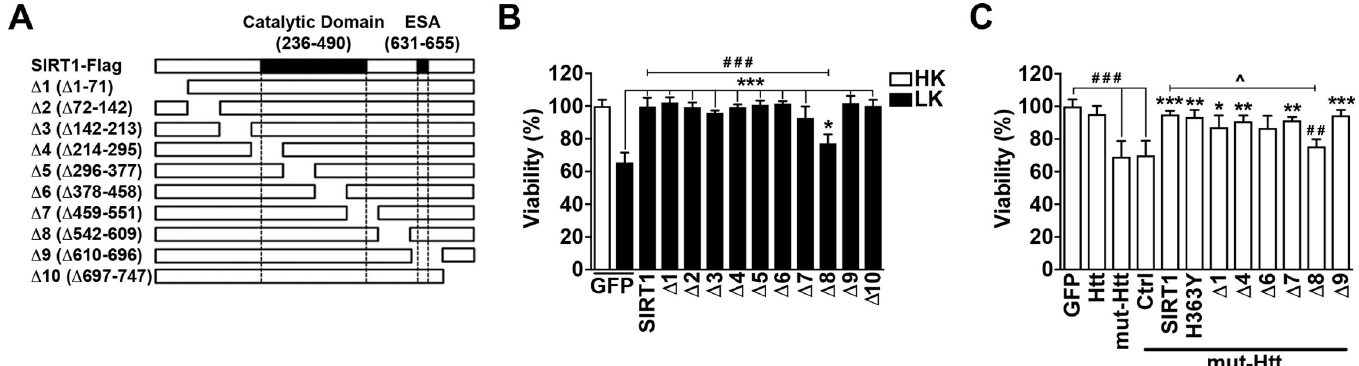
Fig 1. Neuroprotection by SIRT1 does not require its deacetylase activity. A. Schematic of the Flag-tagged SIRT1 and ten deletion constructs used in this study (adapted from [40]). ESA: E ssential for S IRT1 A ctivity motif. B. Full length SIRT1, the ten deletion constructs ( Δ 1- Δ 10), and a GFP control were ectopically expressed in CGNs and treated with either HK or LK media. Viability was quantified as described in material and methods ( � p < 0.05 and ��� p < 0.001 as compared to GFP LK; ### p < 0.001 compared to SIRT1; n = 3). C. Htt-GFP, mut-Htt-GFP, and a GFP control were ectopically expressed into CGNs. Additionally, mut-Htt was co-expressed in a 1:2 ratio with either a control vector (Ctrl, 3xFlag), full length SIRT1-Flag, a SIRT1 deacetylase mutant (H363Y-Flag), or Flag-tagged Δ 1, Δ 4, Δ 6, Δ 7, Δ 8, or Δ 9. Cells were then treated with HK media for 24 h and viability was quantified ( � p < 0.05, �� p < 0.01 and ��� p < 0.001 as compared to mut-Htt/Ctrl co-transfected cells; ### p < 0.001 as compared to GFP; ^ p < 0.05 as compared to mut-HTT/SIRT1 co-transfected cells; n = 3).